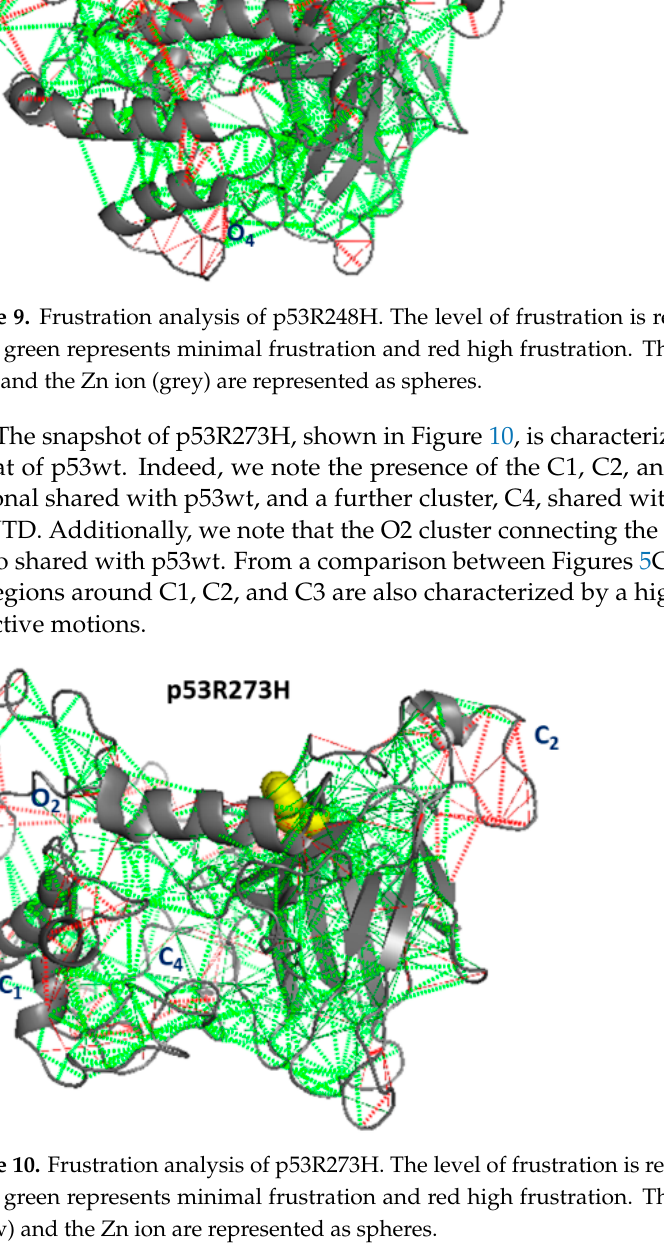
Figure 11 . Frustration analysis of p53R282W. The level of frustration is represented by the colored scale: green represents minimal frustration and red high frustration. The mutated residue (282W, magenta) and the Zn ion (grey) are represented as spheres.